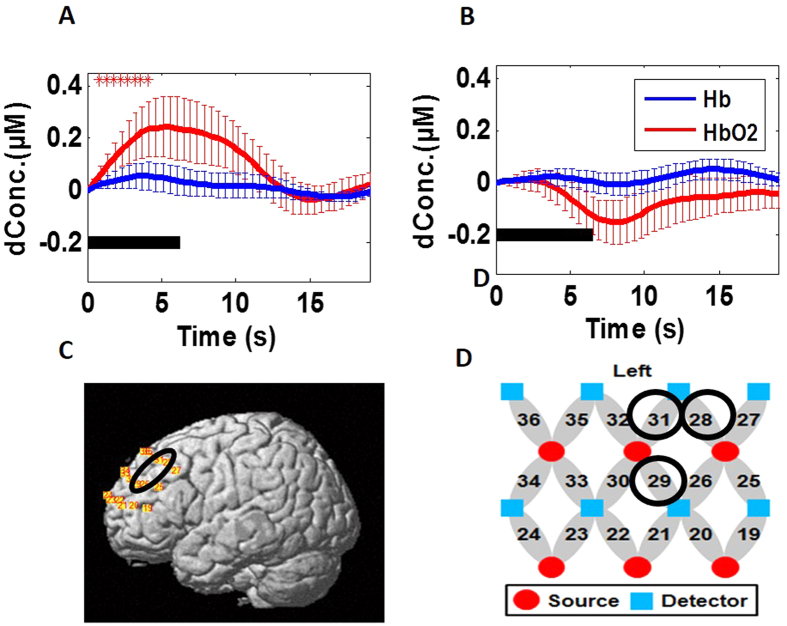
Mean Stroop2-evoked hemodynamic responses from the selected ROI, which includes channels 28, 29 and 31 from left DLPFC, from both groups.(A) Group-averaged, ROI-averaged HbO2 responses from the control group evoked by Stroop2 tasks. (B) Group-averaged, ROI-averaged HbO2 responses from the PTSD group evoked by Stroop2 tasks. In both panels, the thick black lines represent the stimulation period; the thick red lines represent the mean time courses of changes in HbO2; the thick blue lines represent the mean time courses of changes in Hb; the error bars represent standard errors of mean. Asterisks ‘*’ indicate significant (p < 0.05) HbO2 responses with respect to the mean baseline at different time points.